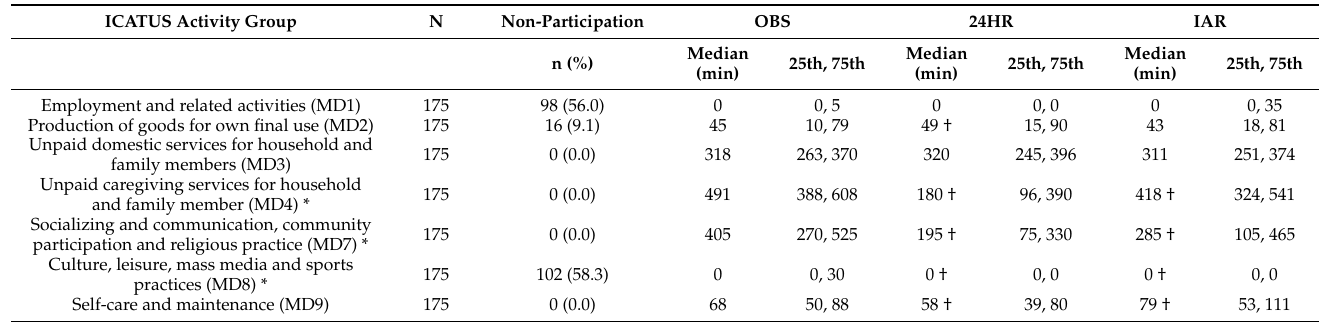
Table 2. Inter-method comparison of the median time allocated in minutes to activity groups. (Median value, and 25th and 75th